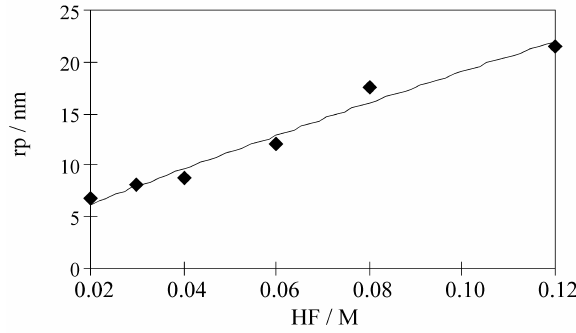
Figure 2. Average pore radius as a function of HF concentration. Table 1. Values of gelation time (t gel ), specific surface area (S P ), specific pore volume (V P ) and average pore radius (r P ) for the silica gels obtained through acid catalysis of TEOS using HCl, HNO 3 and HF.